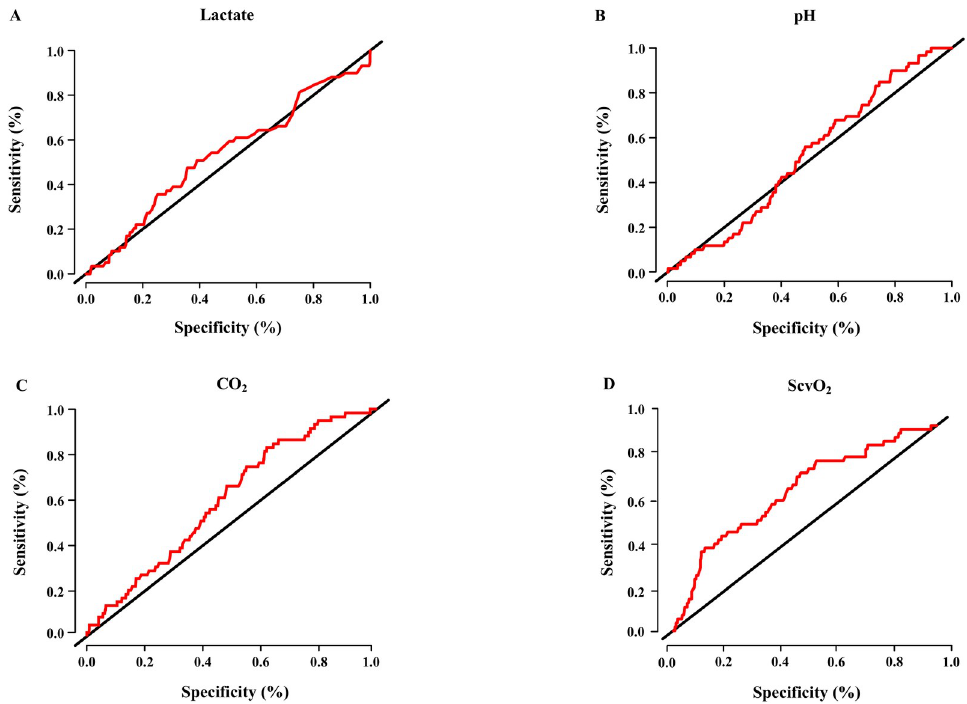
Fig 4. Receiver operating characteristics analysis for lactate, pH, CO 2 , ScvO 2 and the development of intestinal ischemia. Panel A lactate: Area under the ROC curve: 0.5324; sensitivity 86.44% and specificity 16.2% for a cut-off value of lactate � 2mmol/l; Panel B pH: Area under the ROC curve: 0.52; sensitivity 90% and specificity 21%; Panel C CO 2 : Area under the ROC curve: 0.6017; sensitivity 83% and specificity 38%; Panel D ScvO 2 : Area under the ROC curve: 06786.; sensitivity 77% and specificity 52%; ROC = Receiver operating